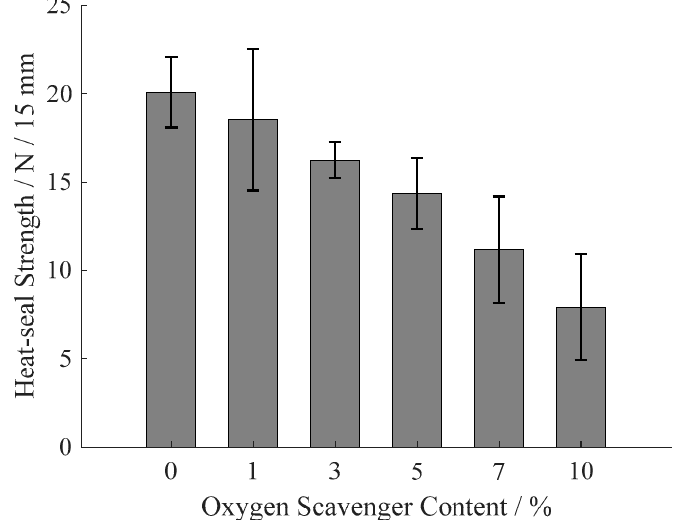
Figure 11. Heat sealing strength of the prepared films under different oxygen scavenger content.